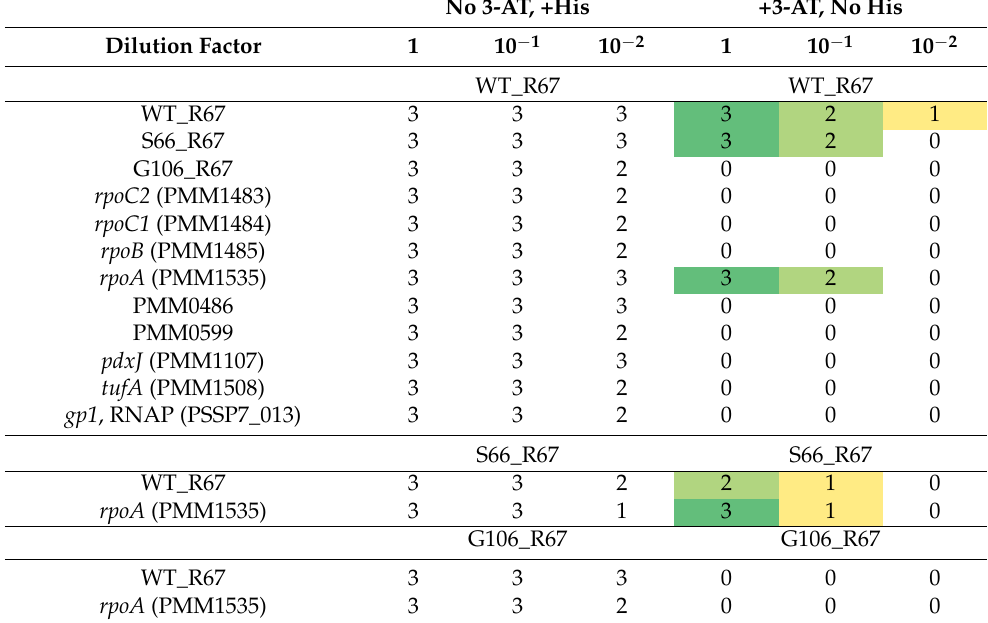
Table 2. Overview of the tested interactions between pMarR and potential interaction partners by yeast two-hybrid assays. Experiments were conducted in biological triplicates (Figure S9) and numbers correspond to the number of replicates where cell growth was observed. Individual co- transformants were spotted in serial dilutions in 10-fold increments on plates containing CSM +His or CSM -His supplemented with 5 mM 3-amino1,2,4-triazole (3-AT). Interactions observed in three, two, or one replicate(s) are marked in dark green, light green, and yellow,